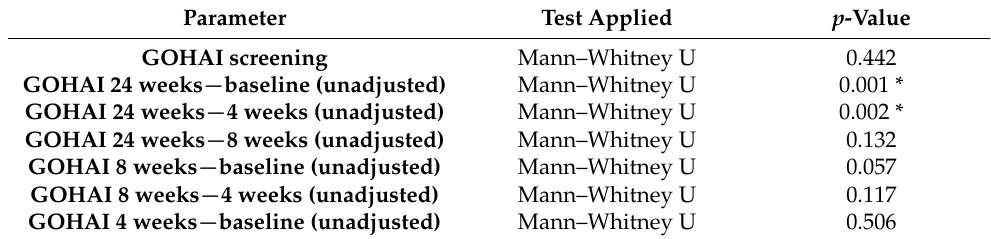
Table 6. Comparison of the GOHAI scores, statistical tests, and corresponding p -values. Parameter Test Applied p -Value GOHAI screening Mann–Whitney U 0.442 GOHAI 24 weeks − baseline (unadjusted) Mann–Whitney U 0.001 * GOHAI 24 weeks − 4 weeks (unadjusted) Mann–Whitney U 0.002 * GOHAI 24 weeks − 8 weeks (unadjusted) Mann–Whitney U 0.132 GOHAI 8 weeks − baseline (unadjusted) Mann–Whitney U 0.057 GOHAI 8 weeks − 4 weeks (unadjusted) Mann–Whitney U 0.117 Mann–Whitney